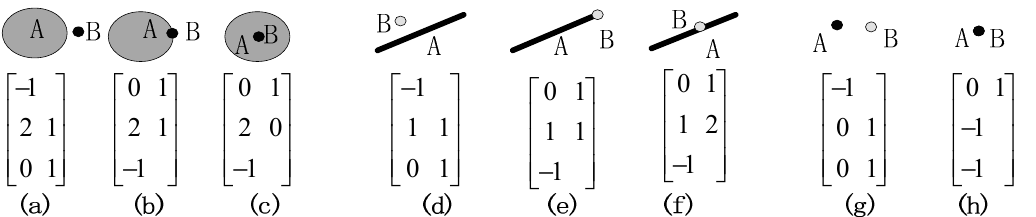
Figure 22. Topological relations between points/regions, points/lines, and points/points, as discriminated by the E-WID model. ( a ) Region A and point B are disjoint; ( b ) Point B is on the boundary of region A ; ( c ) Point B is inside of region A ; ( d ) Line A and point B are disjoint; ( e ) Point B is on the boundary of line A ; ( f ) Point B is inside of line A ; ( g ) Point A and point B are disjoint; ( h ) Point A is equal to point B .